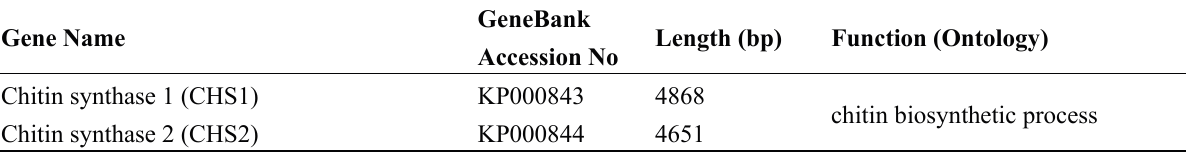
Table 3. The major enzyme genes involved in chitin metabolism in C. medinalis